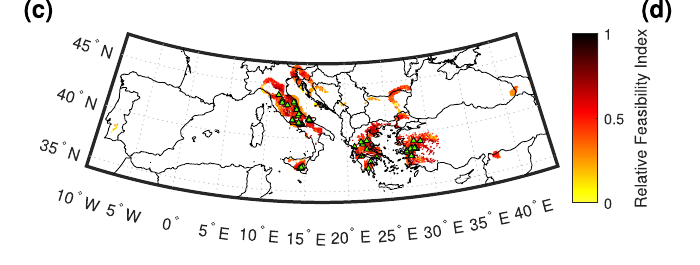
Fig. 9 Relative feasibility index mapping across examined target sites. Indices for a the case in which lead time, intensity, and population are equally weighted by a stakeholder, as well as differences for cases in which b lead time, c seismic intensity, and d population are respectively weighted three times more than both other variables. Also shown are e equally weighted indices modi fi ed in line with the relative number of correctly issued alerts (for a 0.05 g alert threshold) 19 . Note that for b – d , red colours indicate an increase in the index relative to a and blue colours indicate a relative decrease. Green triangles indicate target sites with one of the 50 largest indices for each